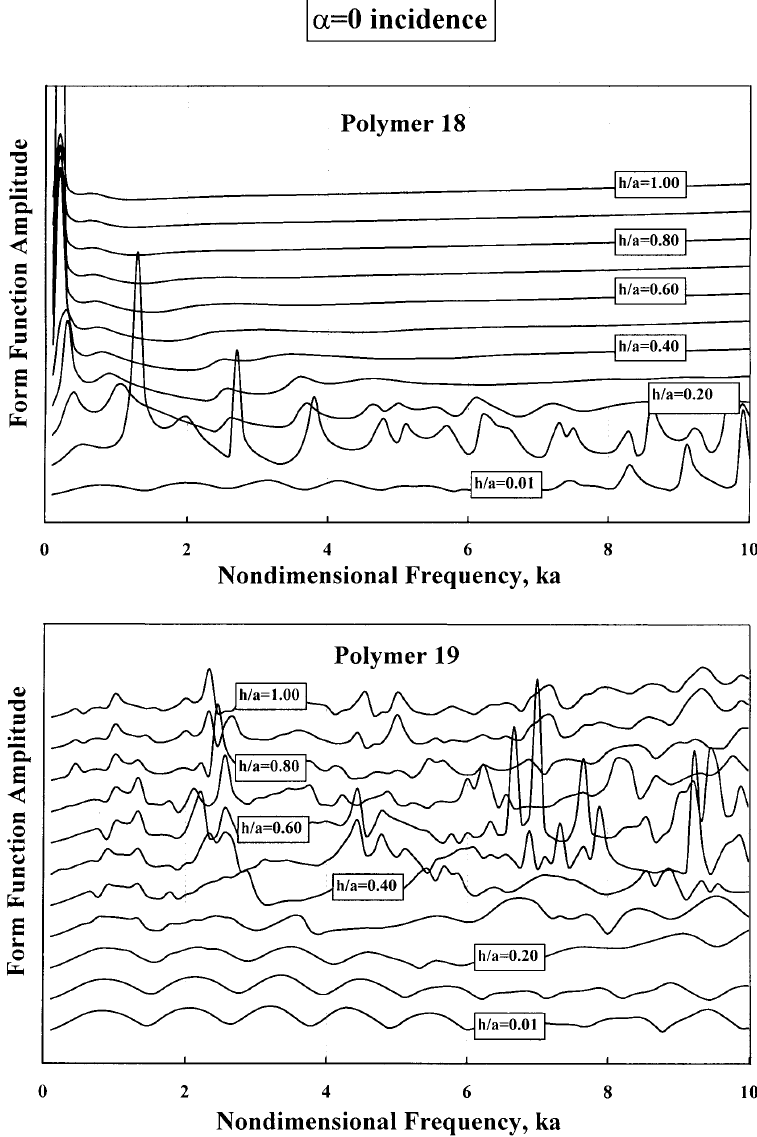
Fig. 8. Variation of the form function for the fluid-filled cylindrical viscoelastic shell with the shell thickness at normal wave incidence ( α = 0 ). acting on the viscoelastic spherical shell with nondimensional frequency of the incident wave and shell thickness are presented in Fig. 5. The results are plotted in dimensionless form; namely, they are the acoustic radiation force per unit area and per unit pressure of the incident wave for the spherical shell. Once again, similar behaviour as in the previous two figures is observed. Here, the dimensionless force coefficients are almost linearly proportional to the dimensionless wave number ka when the frequency of the incident wave is low (i.e., ka < 1 ). The linearity breaks down when the incident wave frequency increases. Also, recurring peaks in the force amplitudes of the polymeric shell 18 are observed for h/a (cid:2) 0 . 4 . Adding to the thickness of polymeric shell 18 (i.e., h/a > 0 . 5 ) has in general no considerable effect on the force magnitudes as they become almost identical and non-oscillatory (i.e., there is only a single peak observed near ka = 1 ). A more regular pattern is noted for polymeric shell 19, especially at low shell thicknesses in the entire frequency range. This behaviour could be due to its lower loss factor and higher